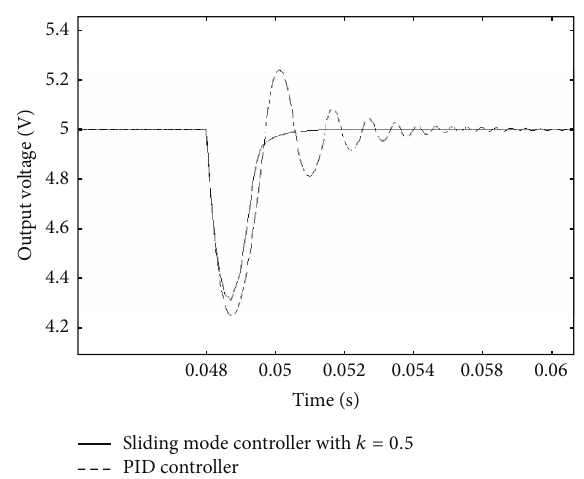
Figure19:TheDC/DCoutputvoltagevariationaboutloadvariation